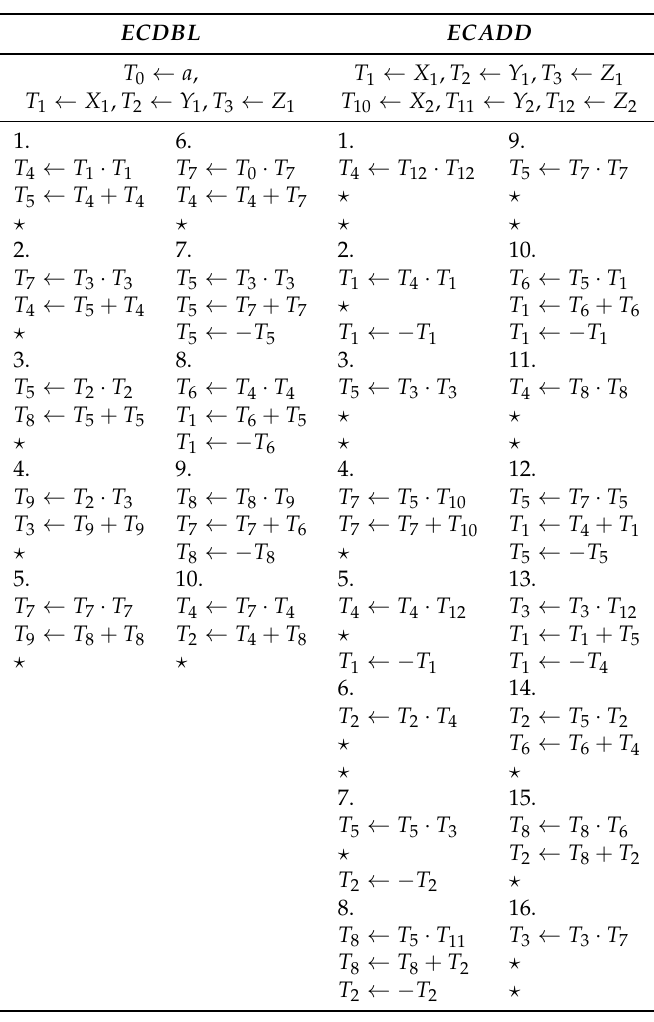
Table 7. Proposed atomic block method.